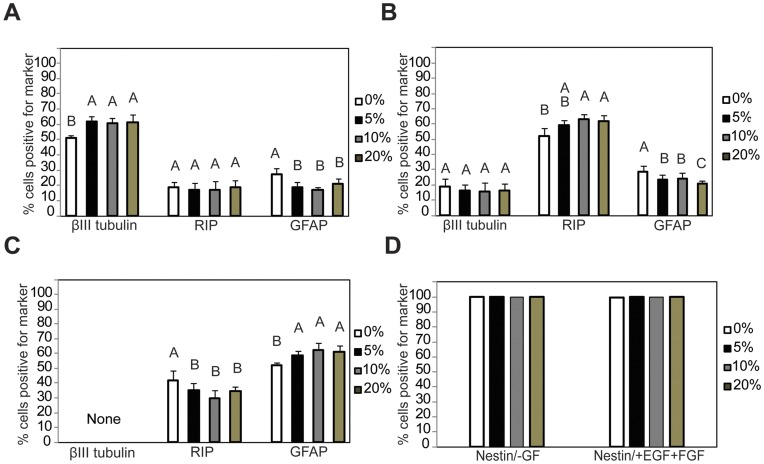
Fluorescence staining results for NSPC differentiation.Quantification of IHC at day 14 shows that more porous scaffolds (up to 20 wt% D-mannitol initially) in (A) neuron specific media (IFN-γ) favor neurons. (B) Oligodendrocyte specific media (PDGF-AA) favor oligodendrocytes and (C) in astrocyte specific media (BMP-2) favor astrocytes. (D) Control media with no growth factors (-GF) as well as with proliferation growth factors (+EGF+FGF) maintain nestin expression (note: error bars are included but too small to see). Letters denote significance by single factor ANOVA (p<0.001). Mean ± SD with n = 3.